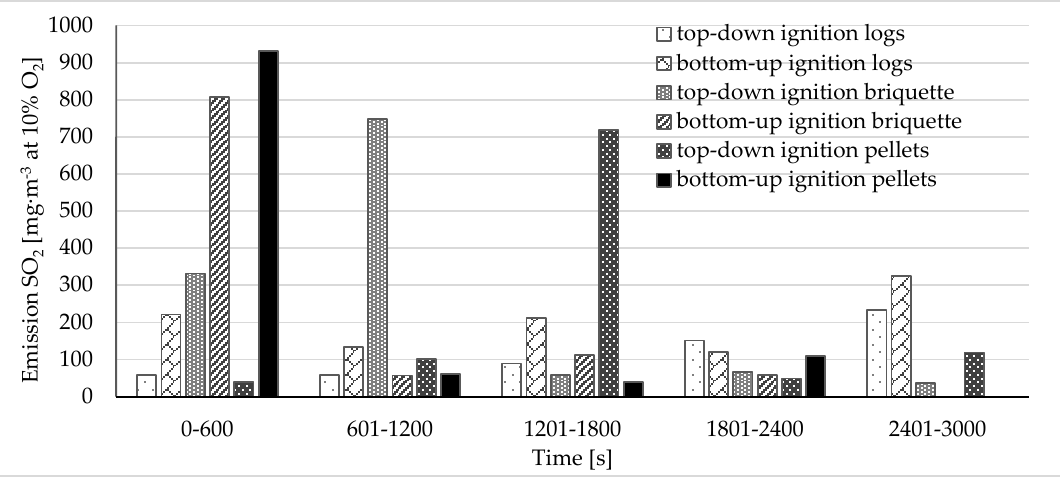
Figure 4. Indicators of sulfur dioxide emission during the combustion of the selected biomass forms.